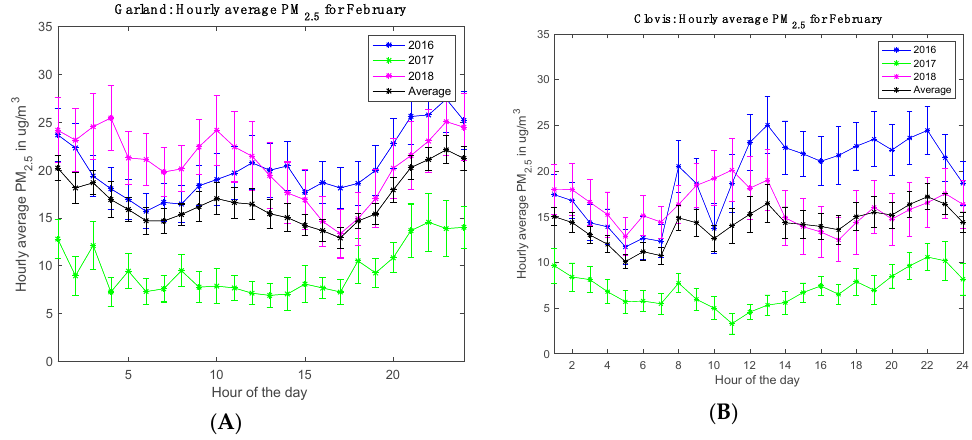
Figure 5. Hourly average PM 2.5 variation for Garland ( A ) and Clovis ( B ) during February. With all winters averaged together, the hourly average PM 2.5 variation for both sites is shown in Figure 6. The figure shows that the Garland and Clovis sites have quite similar hourly PM 2.5 variation